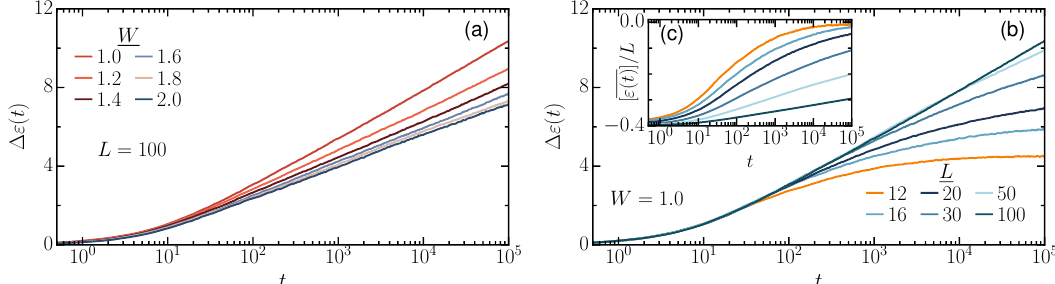
Figure 1: Averaged energy logarithmic growth starting from the ground state of the Anderson model. (a) As a function of disorder strength W for a system size L = 100.(b) As a function of system size L for W = 1.0.(c) Inset showing the satura- tion of the energy density [ (cid:34) ( t )] / L to an infinite-temperature state at long times for the smaller system